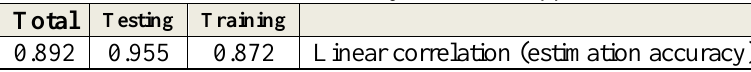
Table 13. Estimation accuracy of vector support machine.